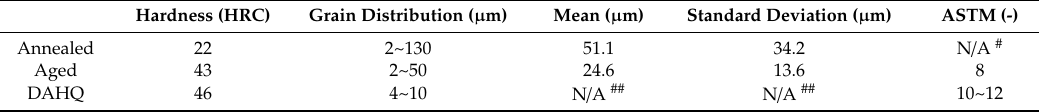
Table 3. Physical properties of Inconel 718 before and after heat treatment.